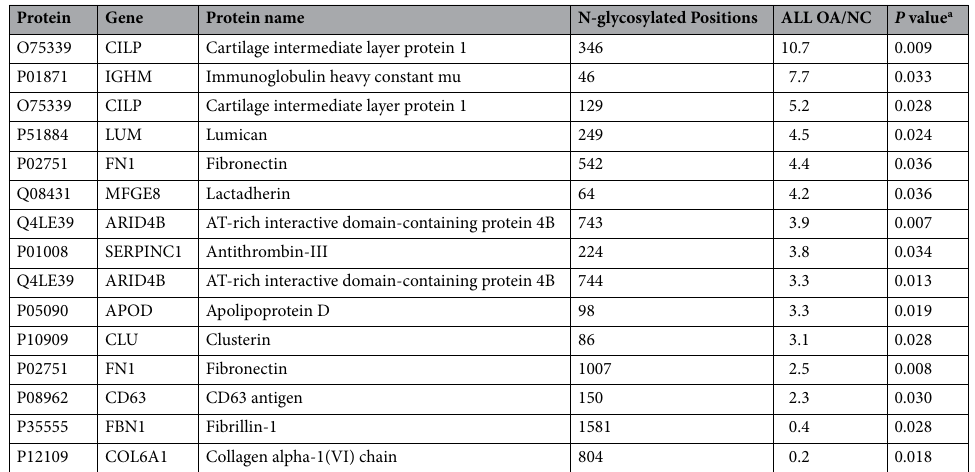
Table 1. N-glycosylated proteins with differential abundance were identified in ALL-OA (OA & DM-OA) group compared to the normal control group. a Wilcoxon non-parametric test.